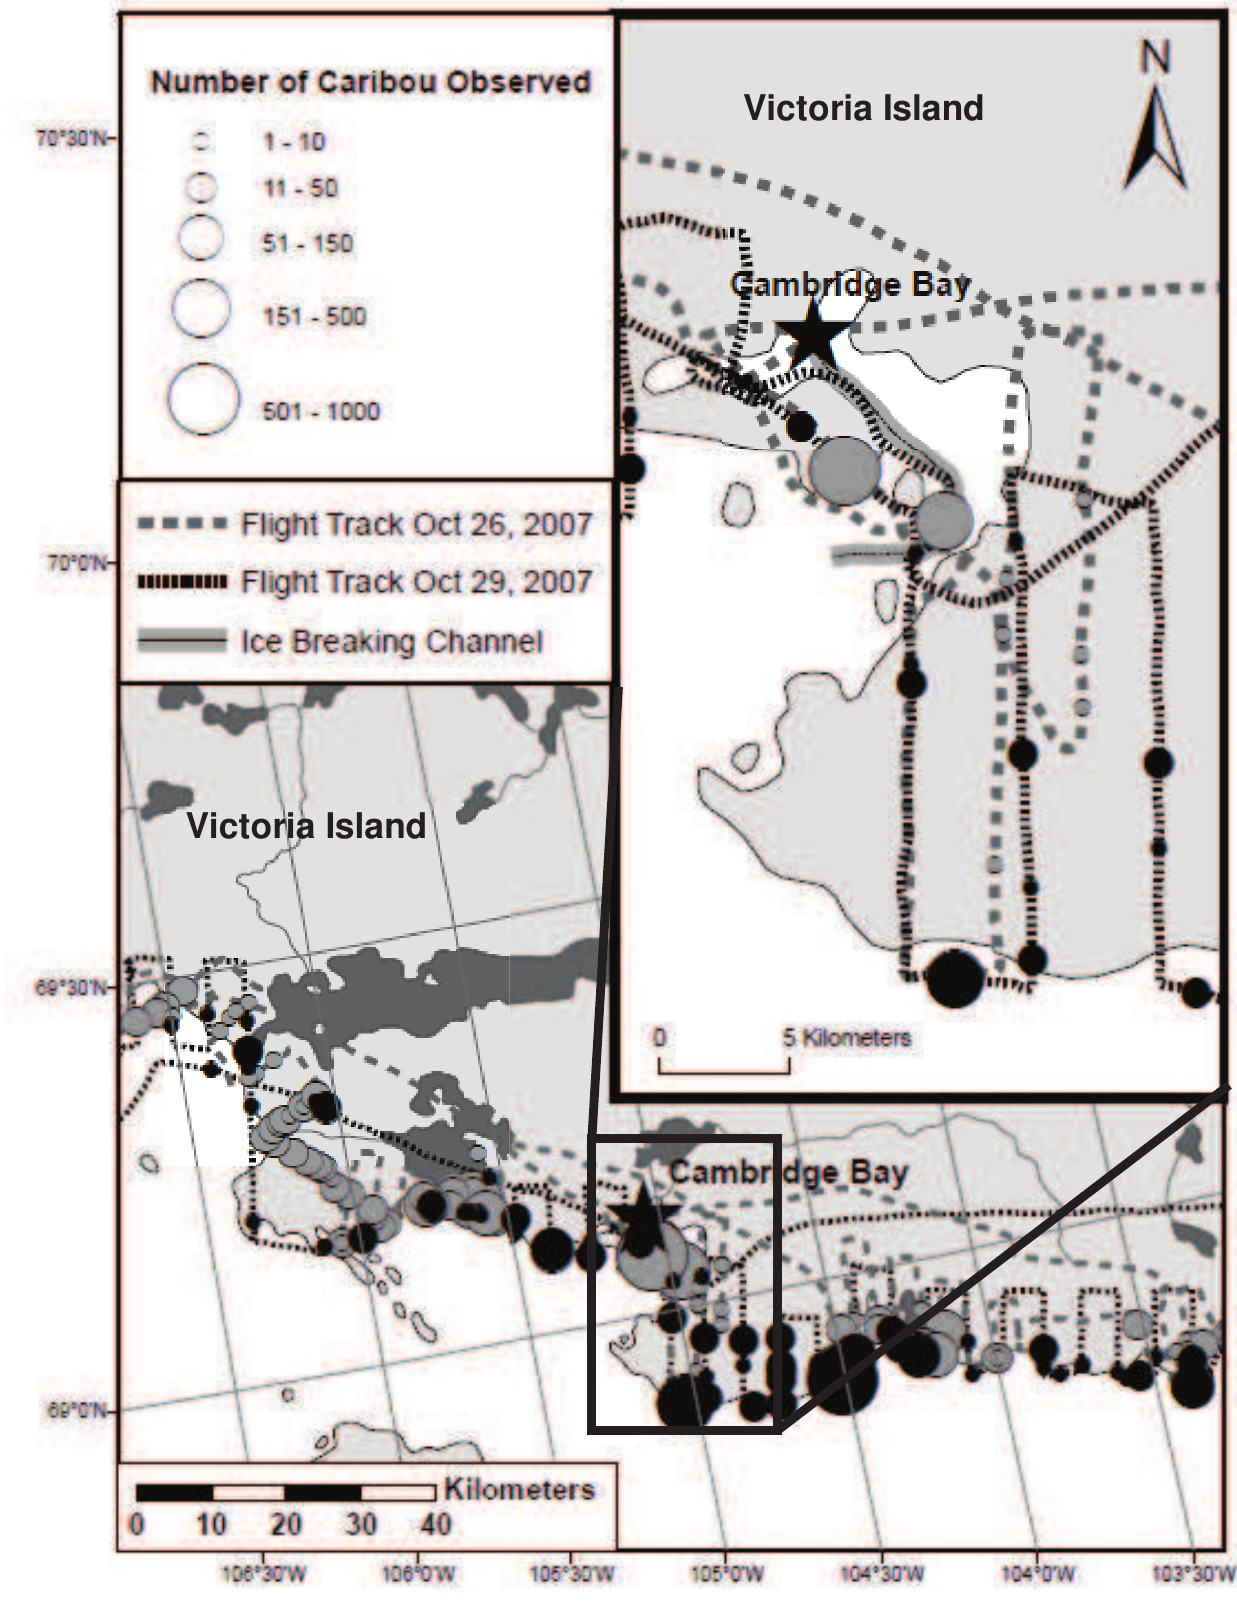
Figure 2. Flight tracks around Cambridge Bay, NU, on October 26 and 29, 2007, with caribou observations (dot size is proportional to caribou group size; October 26 in grey and October 29 in black) and the approxi- mate barge tug-boat ice breaking